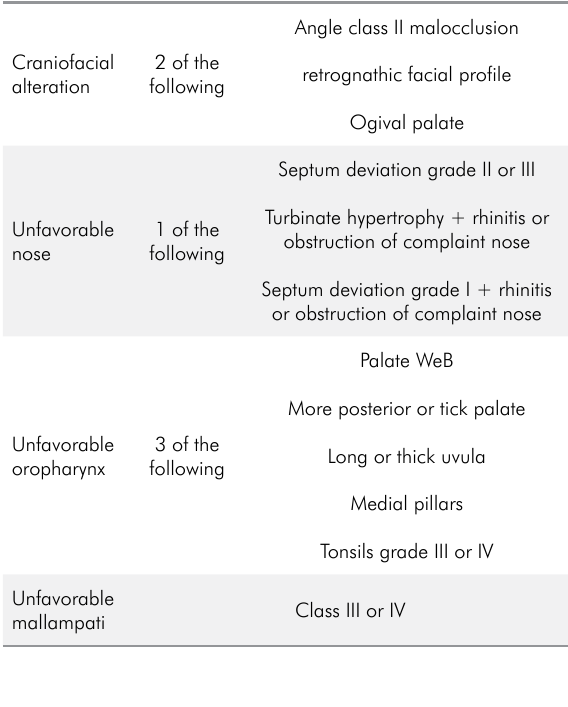
Table 1. Evaluation ENT.